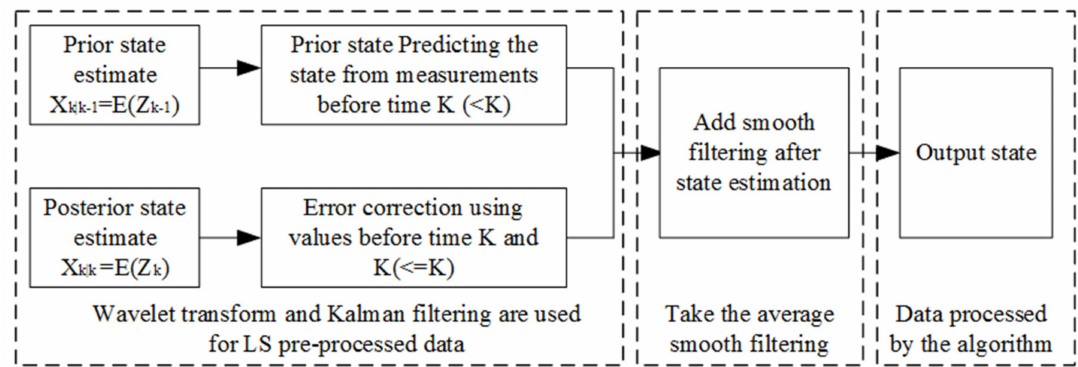
Figure 3. The measurement principle block diagram of the improved Kalman filter algorithm, including two parts of design data processing by algorithm and average value filtering (The method of averaging the observations is called smooth filtering in